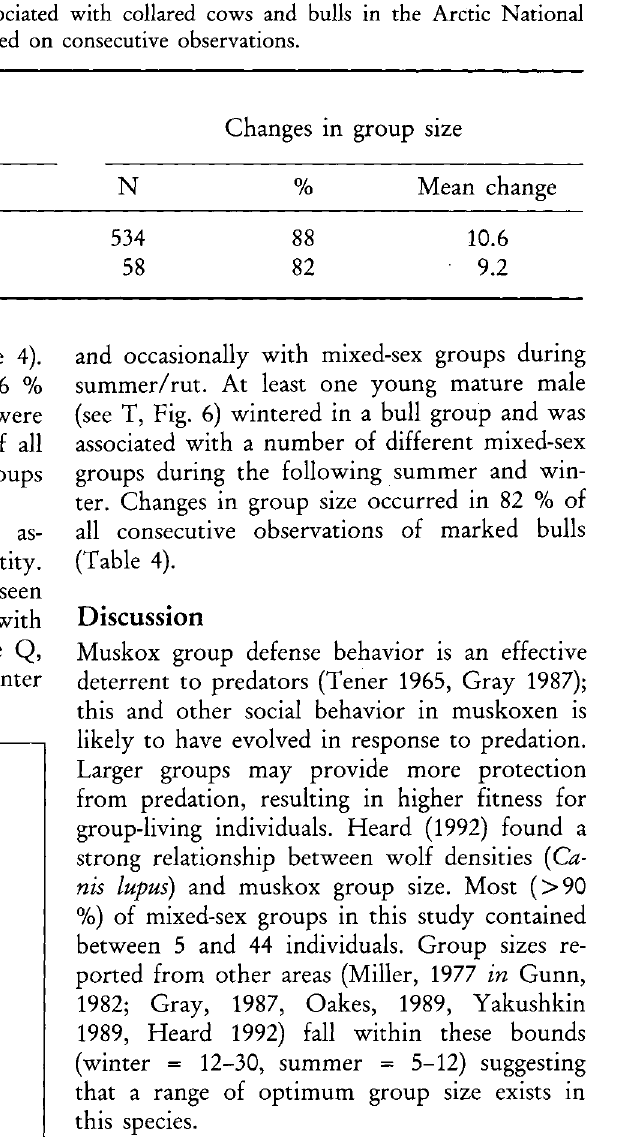
CAPITAL LETTER = MARKED BULL MUSKOX SMALL LETTER = MARKED COW MUSKOX NUMBERS = GROUP SIZE + = SOLITARY BULL OR BULL GROUP * = MIXED-SEX GROUP Fig. 6. An example of changes in size and group identity of groups containing marked bull muskoxen, northeastern Alaska,